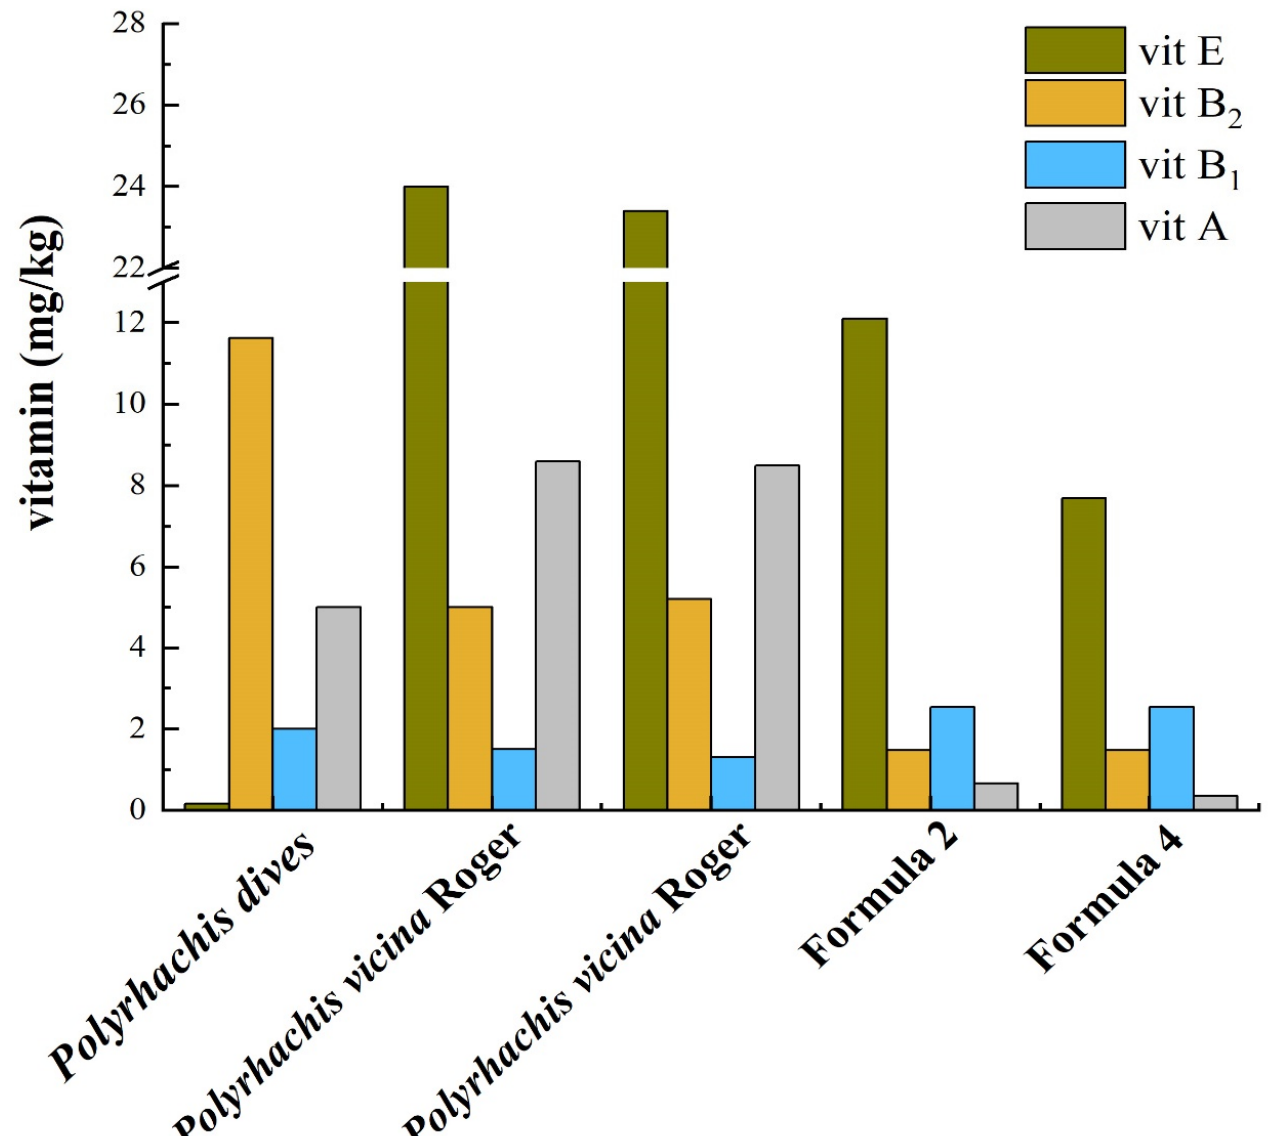
Figure 2. Vitamin concentrations in natural food and formula under human care of pangolins [46– 49]. Notes: Formula 2 includes cat food, ant powder, yellow mealworms, eggs, apples, water, amino acid, astragalus, and trace elements; formula 4 includes cat food, ant powder, yellow mealworms, eggs, apples, carrots, cicada pupas, water, and amino acid. The concentration of vitamin B1 is less than 2 mg/kg, and the concentration of vitamin A is less than 5 mg/kg in Polyrhachis dives .